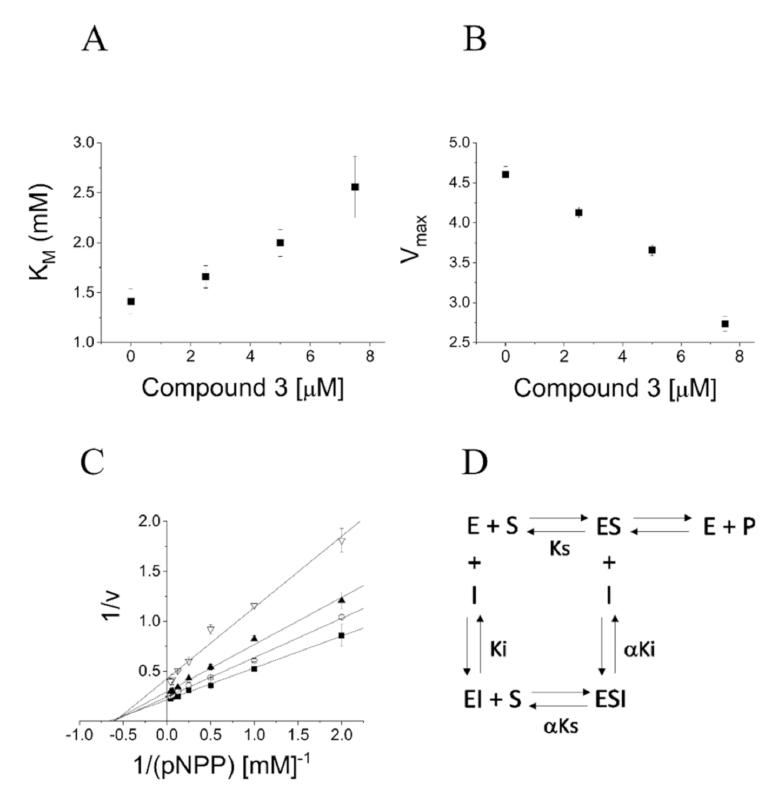
Figure 5. Kinetic characterization of 3 as PTP1B inhibitor. The concentrations of compound 3 used were 0 ( (cid:4) ), 2.5 ( ), 5 ( (cid:78) ) and 7.5 ( (cid:53) ). Dependence of main kinetic parameters K M ( A ) and V max (cid:35) ( B ) from the concentration of compound 3 . Lineweaver-Burk plot ( C ). Bars represent the standard deviations of the means from at least three independent measurements (if not present, they are within the symbol’s size). Panel D shows the mechanism of action of a linear mixed type inhibitor. E, free enzyme; S, substrate; ES, enzyme-substrate complex; EI, enzyme-inhibitor complex; ESI the enzyme- substrate-inhibitory ternary complex; Ks, dissociation constant of the enzyme-substrate complex; Ki, dissociation constant of EI complex; α Ks and α Ki, dissociation constant of enzyme-substrate-inhibitor complex ( α > 1).